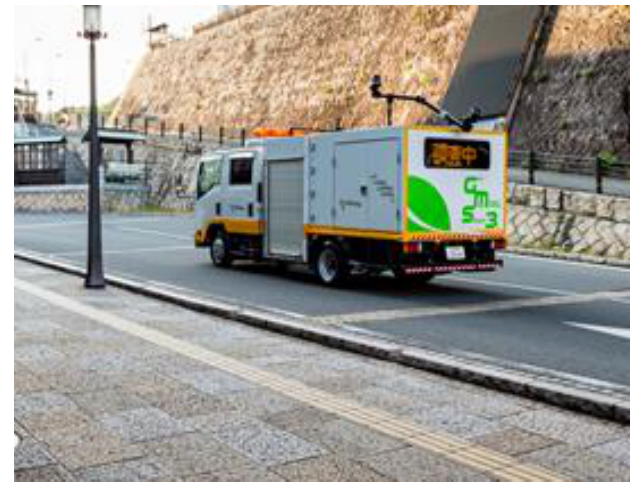
Figure 10. Road Photography with GMS3.